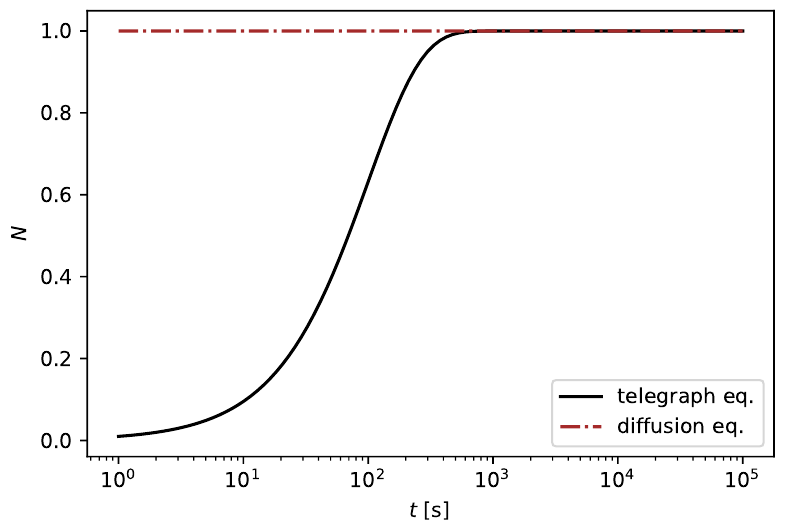
Figure 3. Comparison of the time evolution of the ratio of particles that are already diffusively propagating on average. The solution of the diffusion equation leads to the fact that particles always propagate diffusively. The solution of the telegraph equation shows an increase in the diffusively propagating particles with time and an approach to the maximum